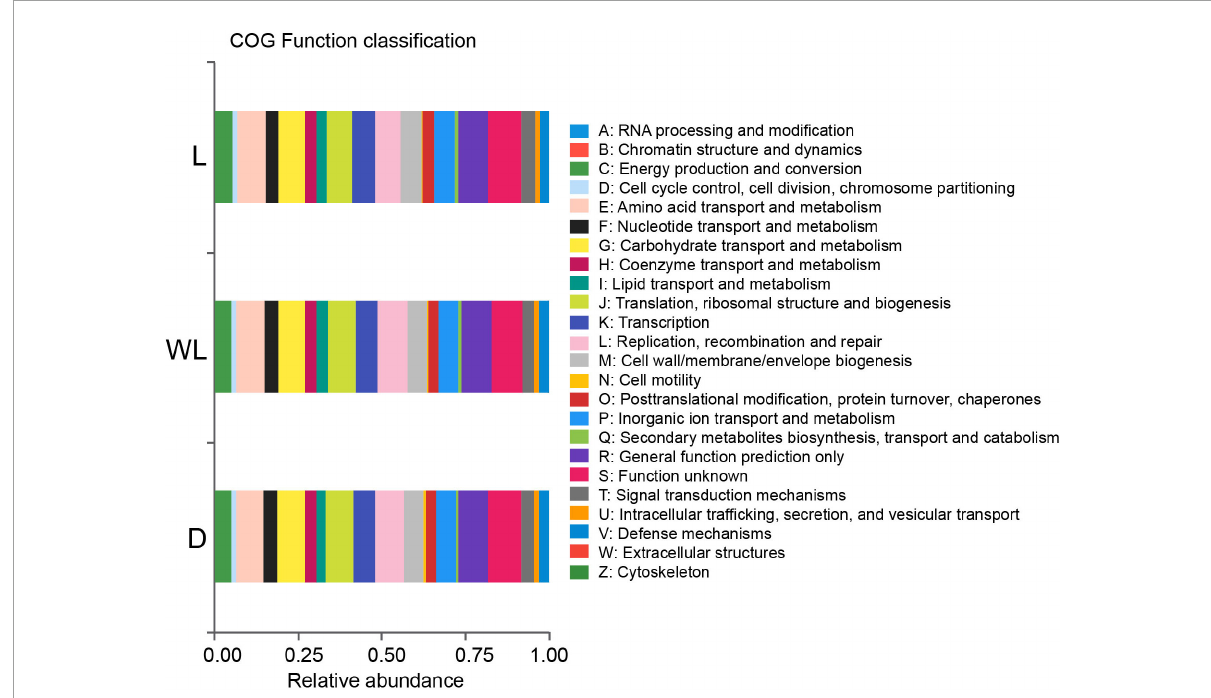
FIGURE4 Relative abundance of gut bacterial function classification, inferred from PICRUSt analysis prediction.